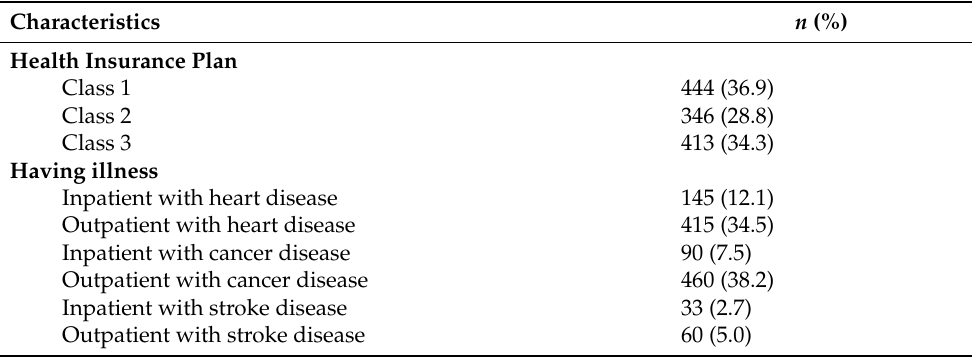
Table 3. Participants’ healthcare characteristics ( n =